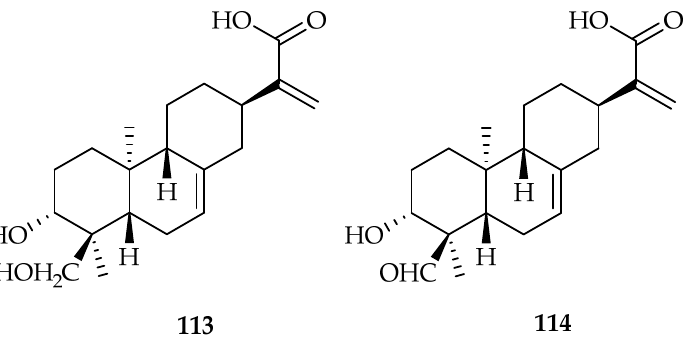
Figure 46. Structures of fischerianoids A 113 and B 114 [70].